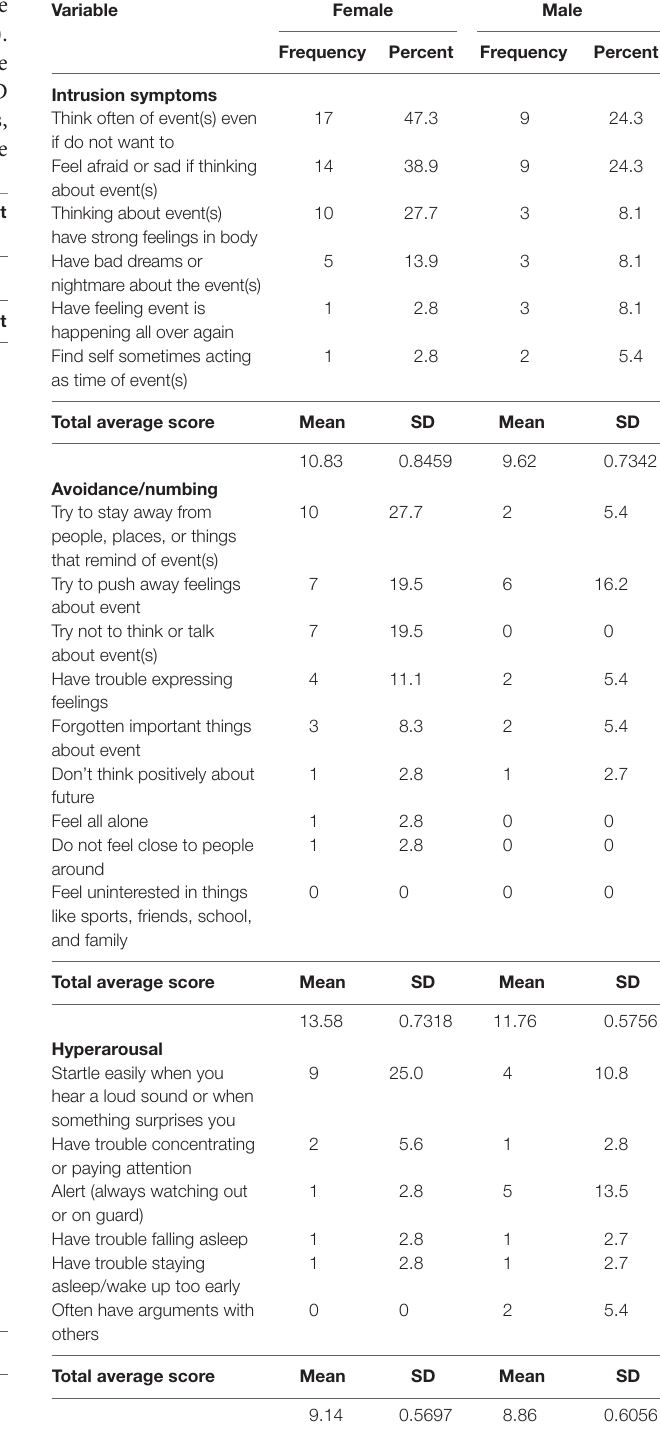
TaBle 4 | Frequency of reactions of child/adolescent iDPs to psycho- trauma – Kaduna, nigeria.